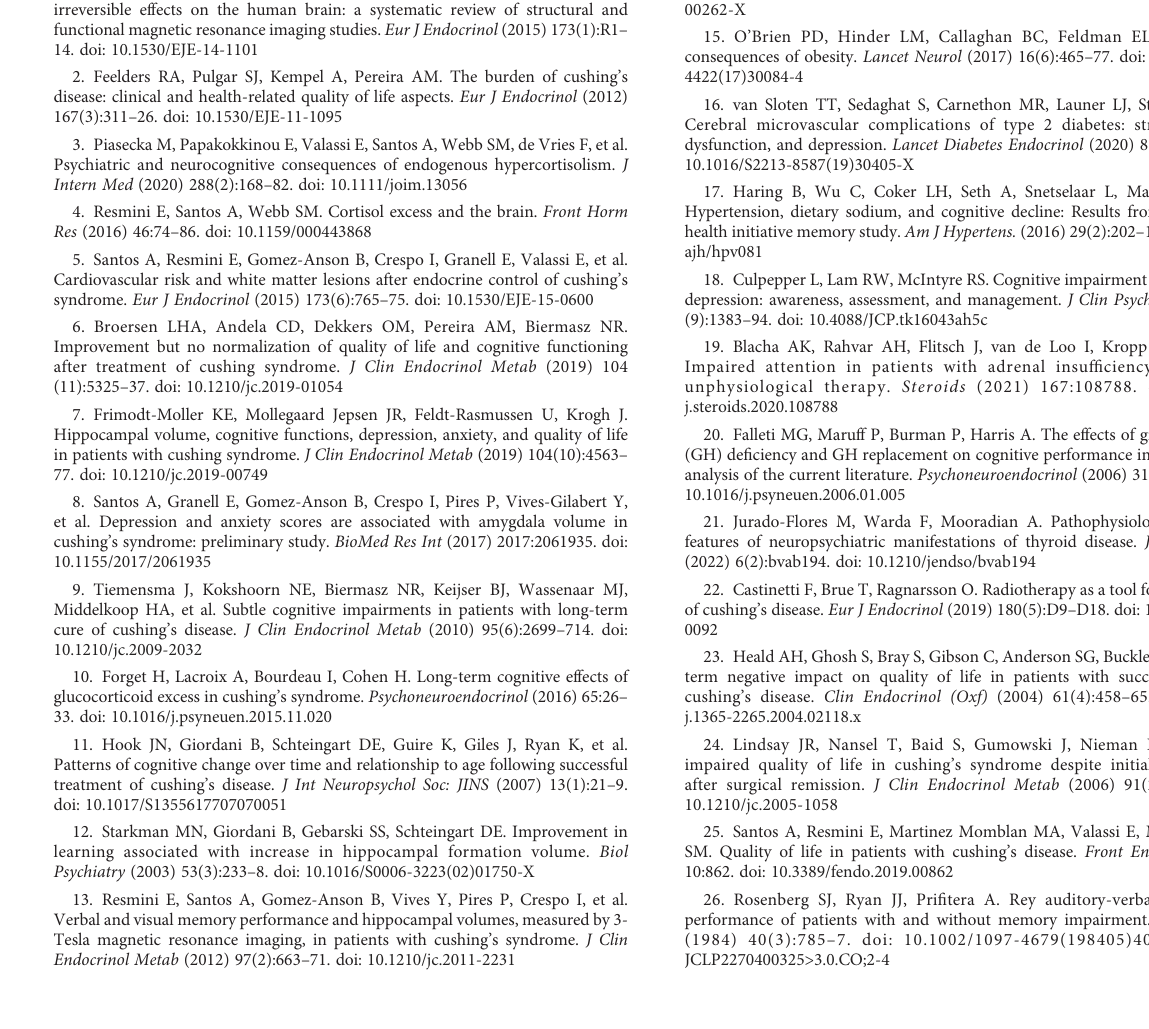
SUPPLEMENTARY DATA SHEET 1 Computerized maze memory tests assessing cardinal features of declarative memory and working memory.